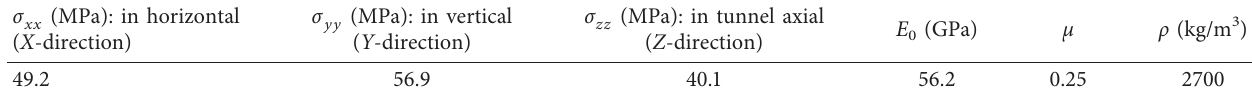
Table 2: Mechanical parameters.